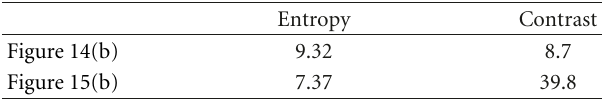
Table 6: Focusing indicators for the real ISAR images of the vessel in Figures 14(b) and